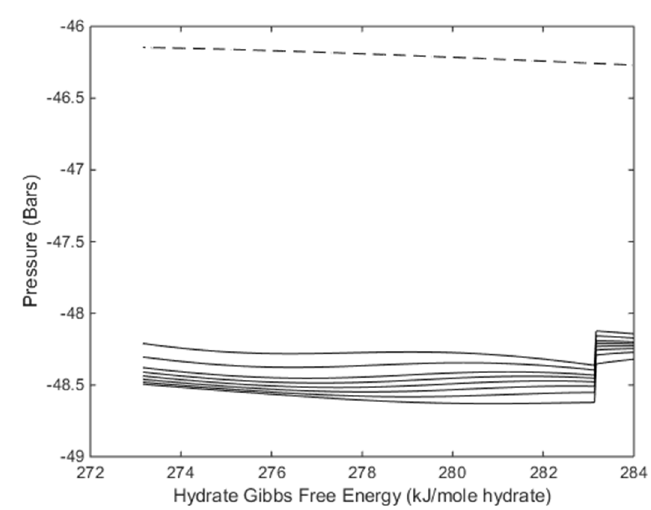
Figure 16. Calculated free energies for formed hydrate along the pressure temperature stability limits in Figure 15. Lowest solid curve is for pure CO 2 , followed by 95 mole per cent CO 2 , then 90 mole per cent CO 2, , then 85 mole per cent CO 2 , then 80 mole per cent CO 2 , then 75 mole per cent CO 2 , then 70 mole per cent CO 2 , then 60 mole per cent CO 2 and upper solid curve for 50 mole per cent CO 2 . Dashed curve is free energy for pure CH 4 hydrate along temperature pressure stability limits.